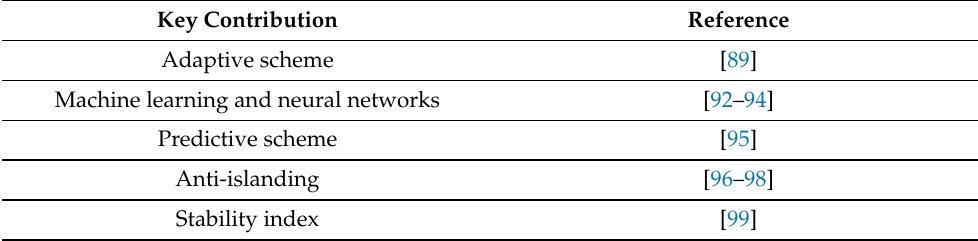
Table 6. Summary of